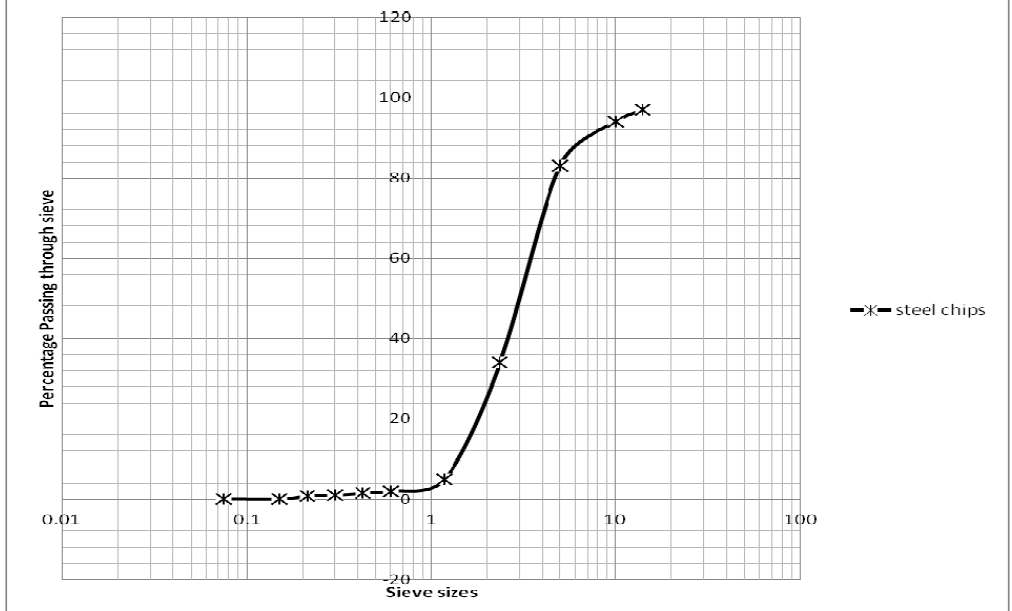
Figure 2. Grading curves for the steel chips on a semi-logarithmic